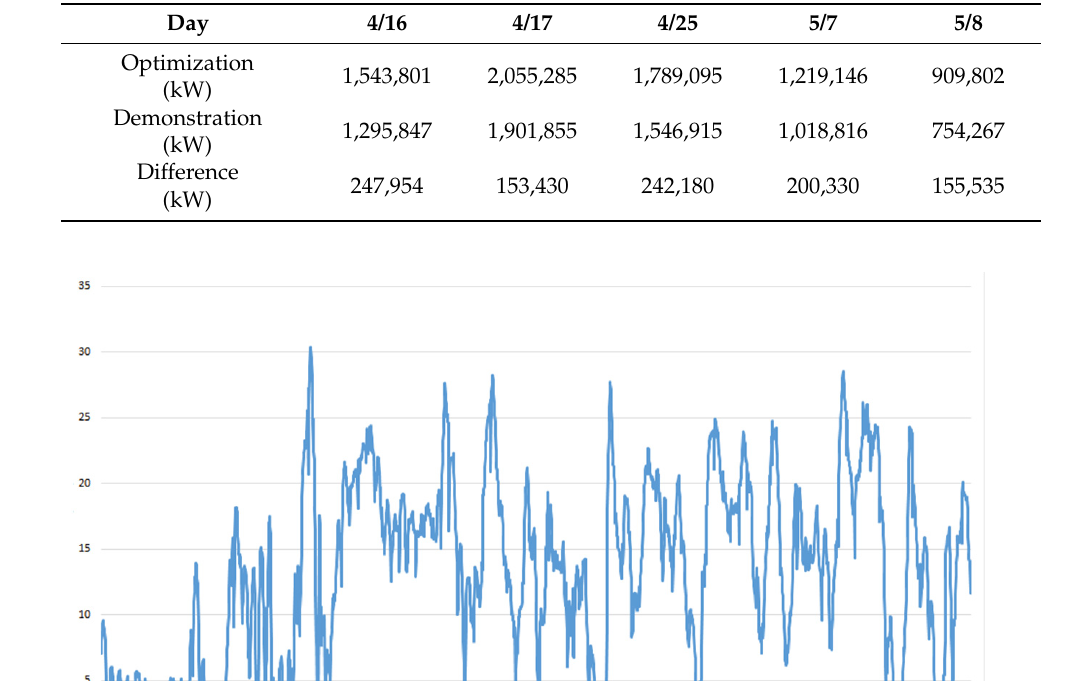
Figure 16. Wind velocity chart between 18 September and 1 January in 2018.